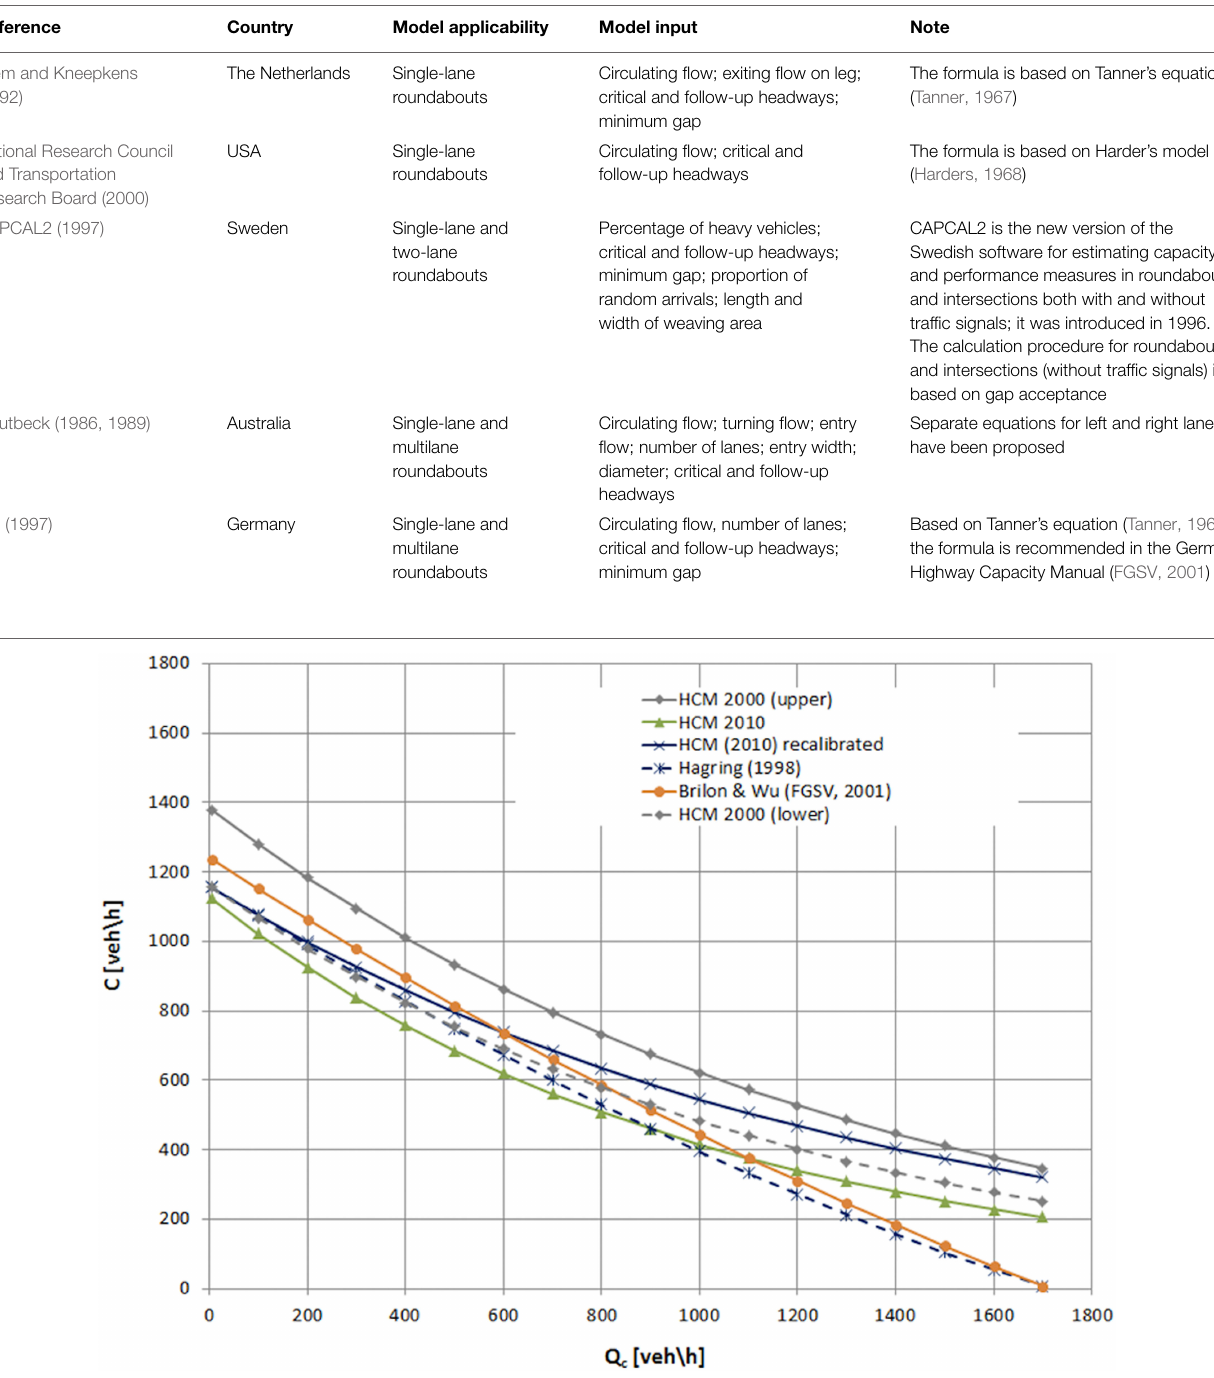
experiencing compared to capacity gives a degree of saturation less than